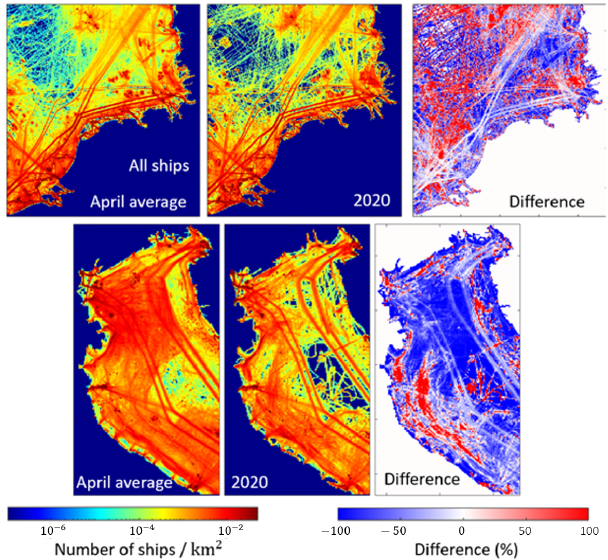
Figure 4. The shipping densities (number of ships per km 2 ) of the test area 1 ( upper ) and test area 2 ( below ) for April Average (over April 2017, 2018 and 2019) and April